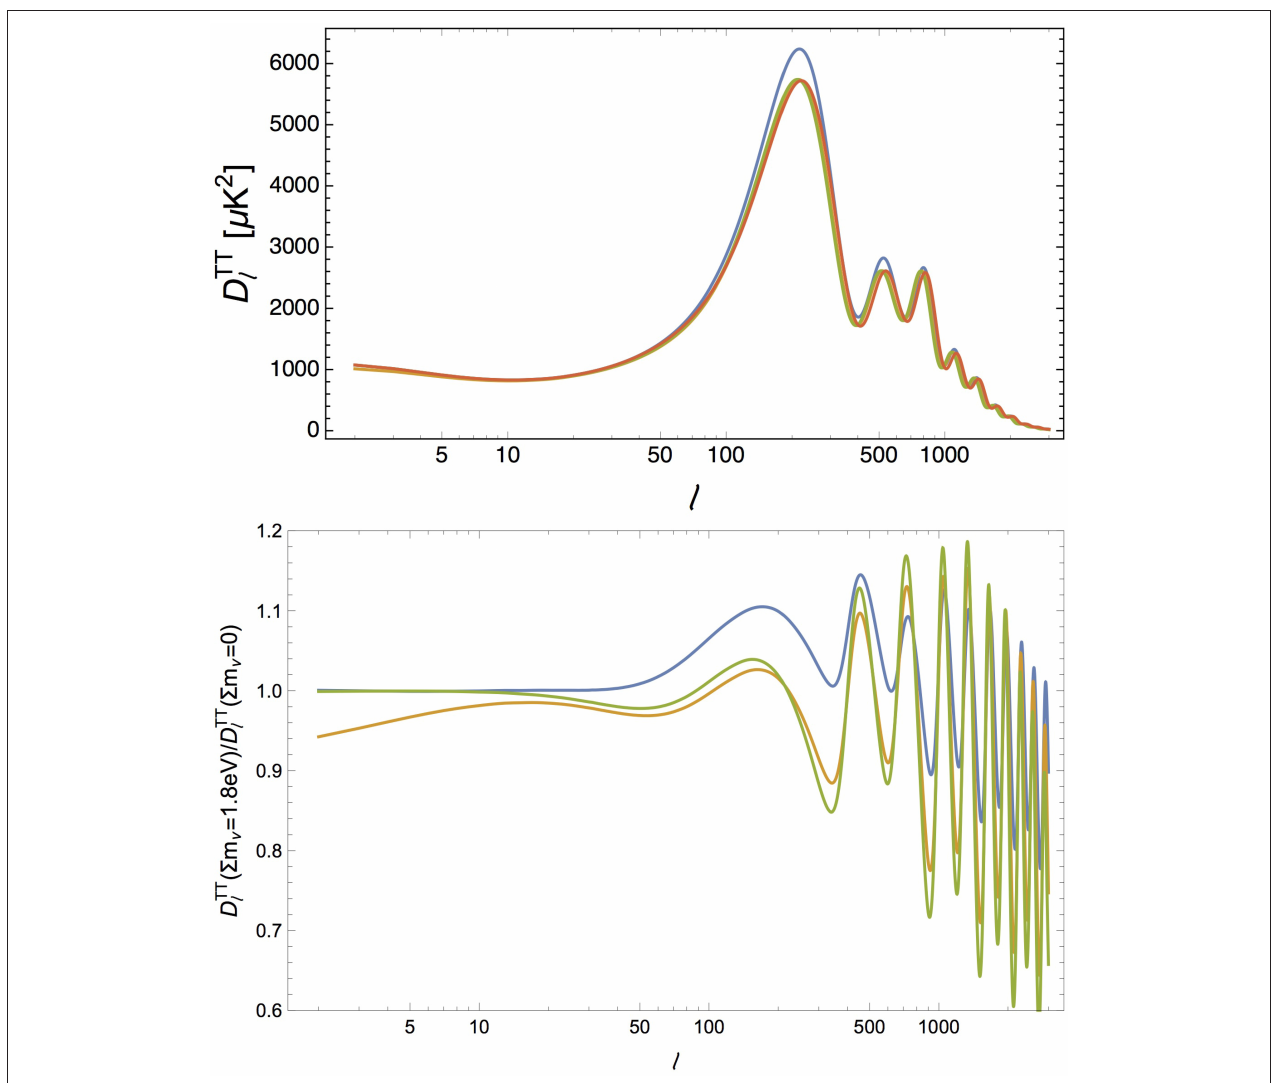
ℓ ( ℓ 1) C TT ℓ / 2 π . The red curve is a cosmological ≡ + 1.8eV, in which the curvature is kept =